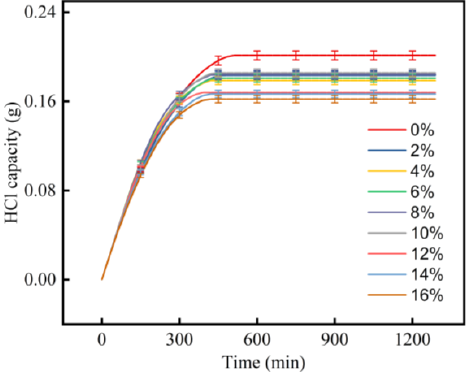
Figure 5. HCl removal capacity using different CO 2 concentrations.